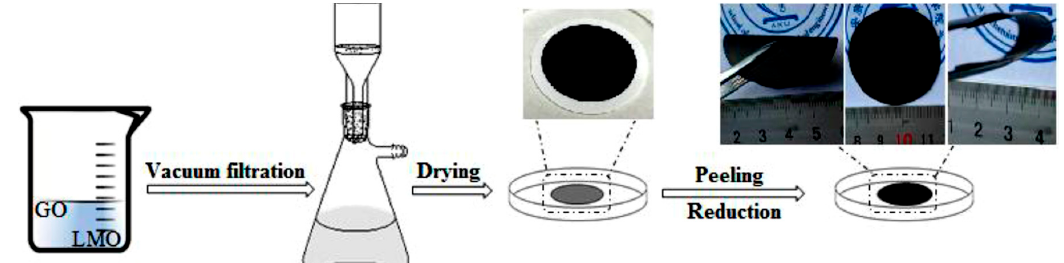
Figure 1. Schematic for the preparation process of the LiMn 2 O 4 -graphene film.